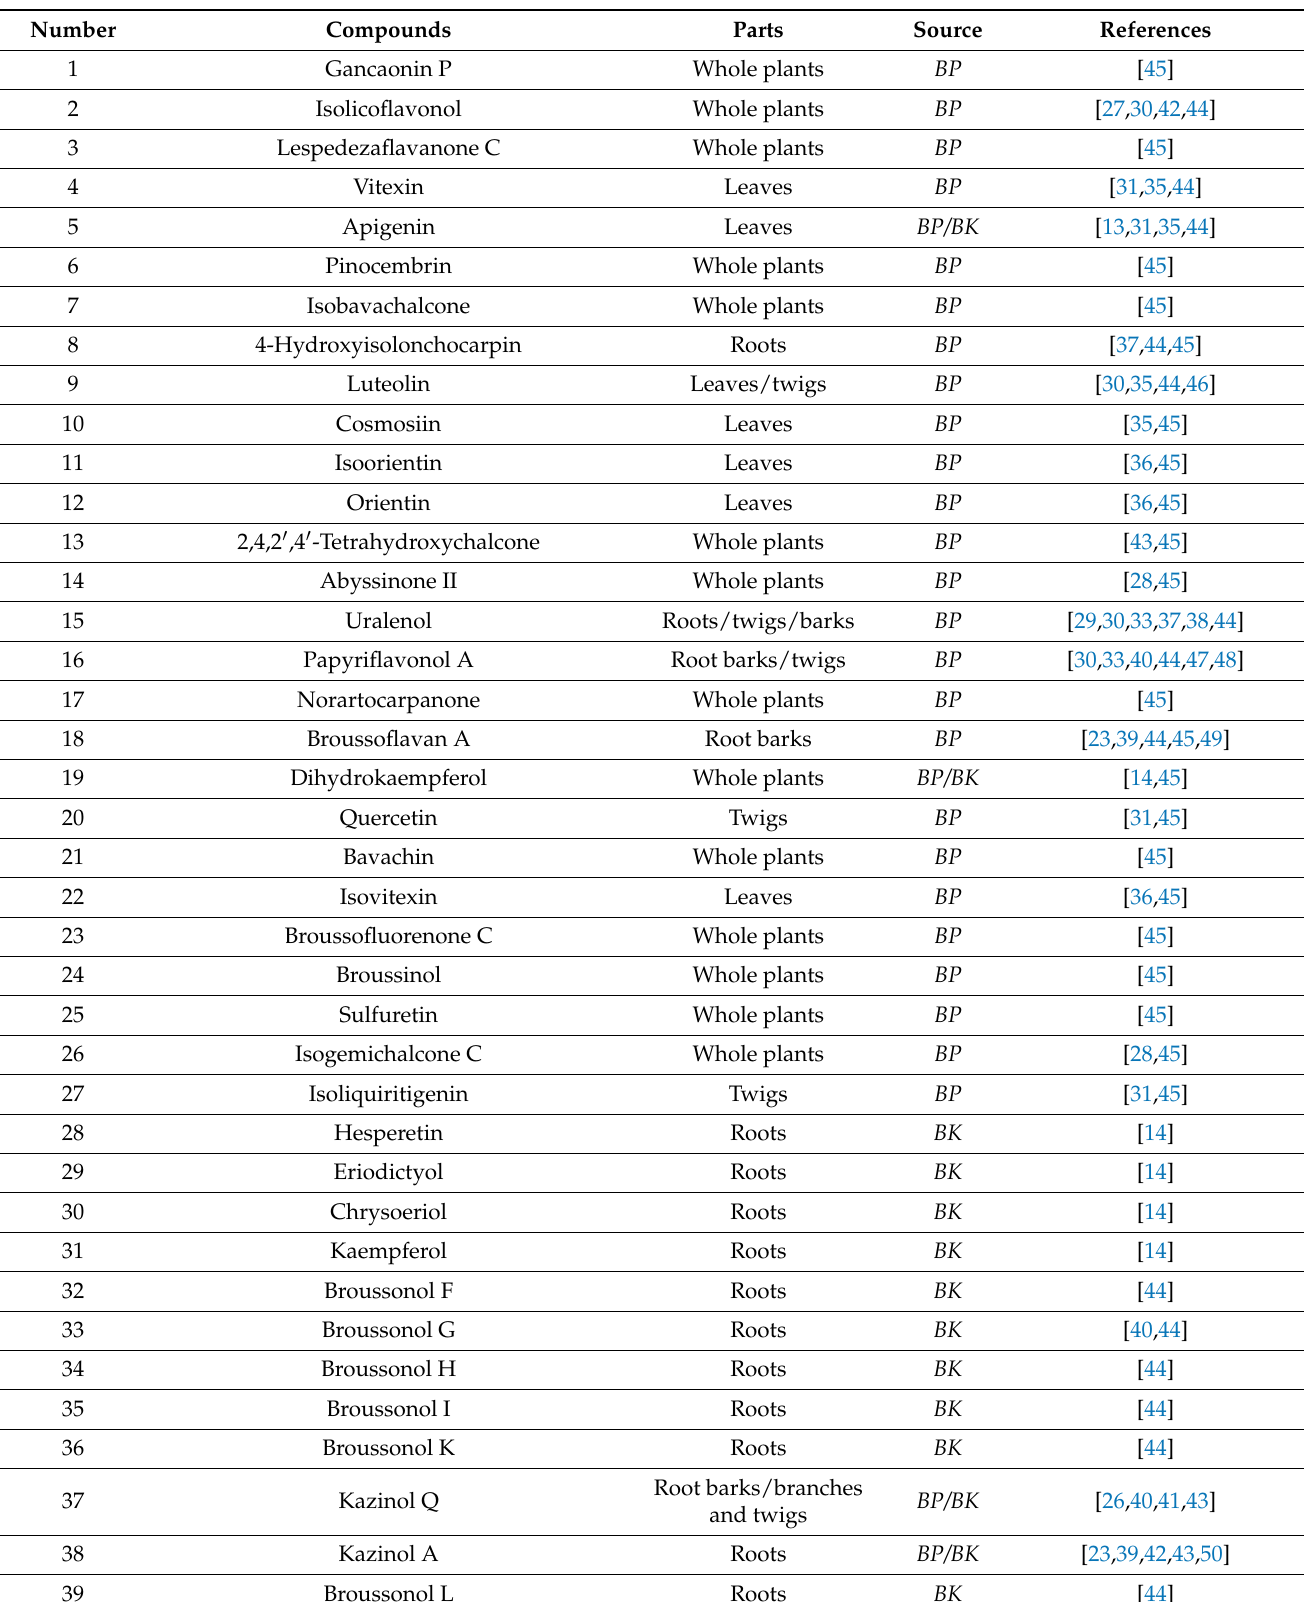
Table 1. Flavonoids isolated from Broussonetia